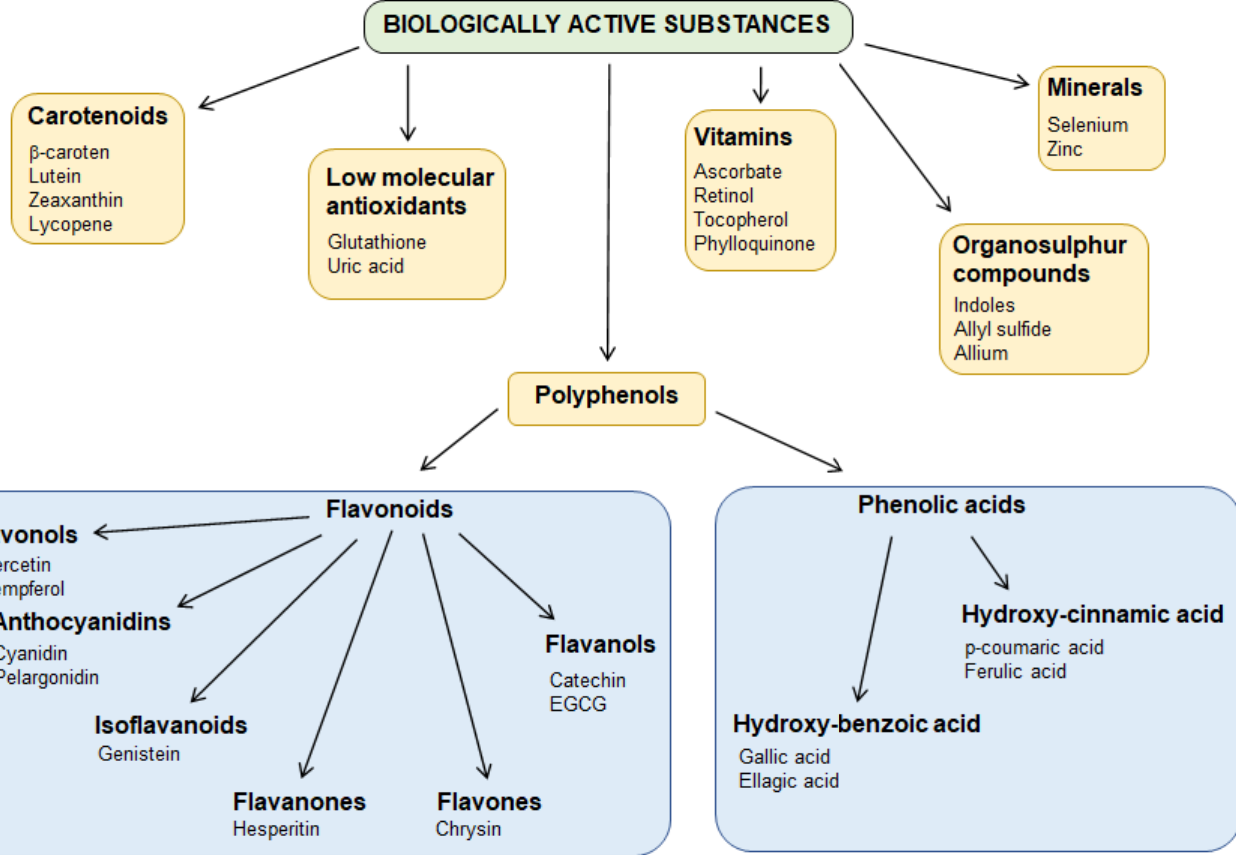
Figure 2. Bioactive substances. Schematic draw of the most abundant bioactive substances in whole plant extracts. plant